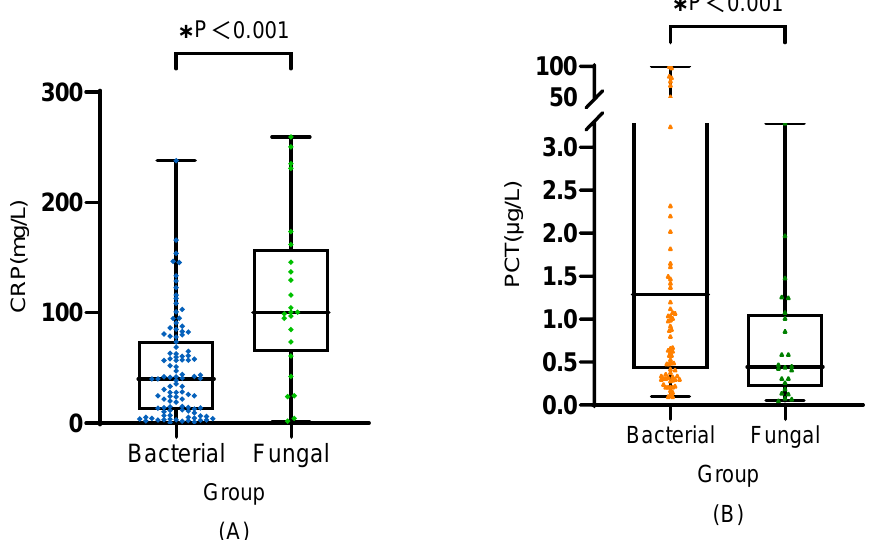
Figure 1. Serum CRP ( A ) and PCT ( B ) in patients with bacterial and invasive fungal infections. The differences between the bacterial group and fungal group were examined using the Wilcoxon rank-sum test. * Wilcoxon rank-sum test. CRP: C-reactive protein; PCT: procalcitonin.